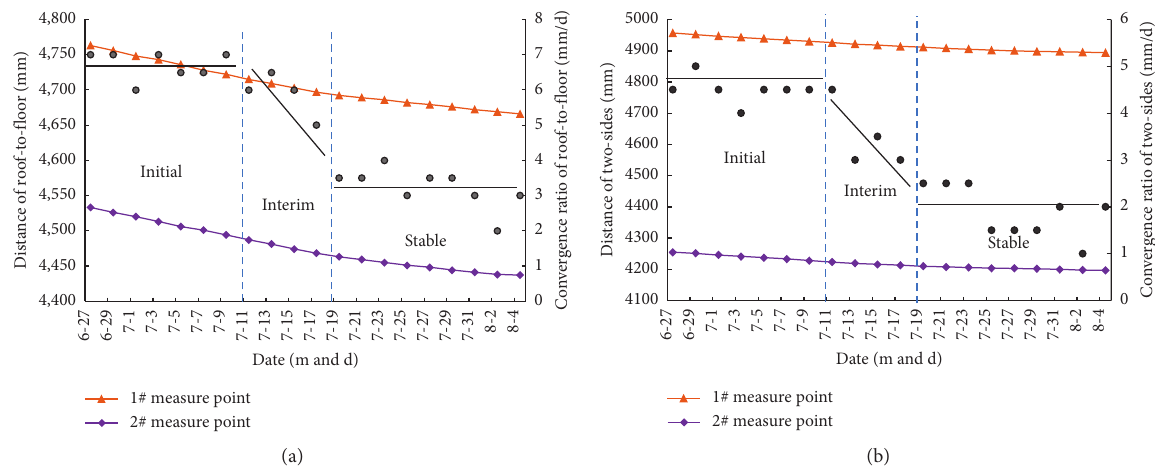
Figure 11: The observation result of the deformation of the surrounding rock in the chamber: (a) convergence of roof-to-floor; and (b) convergence of the two